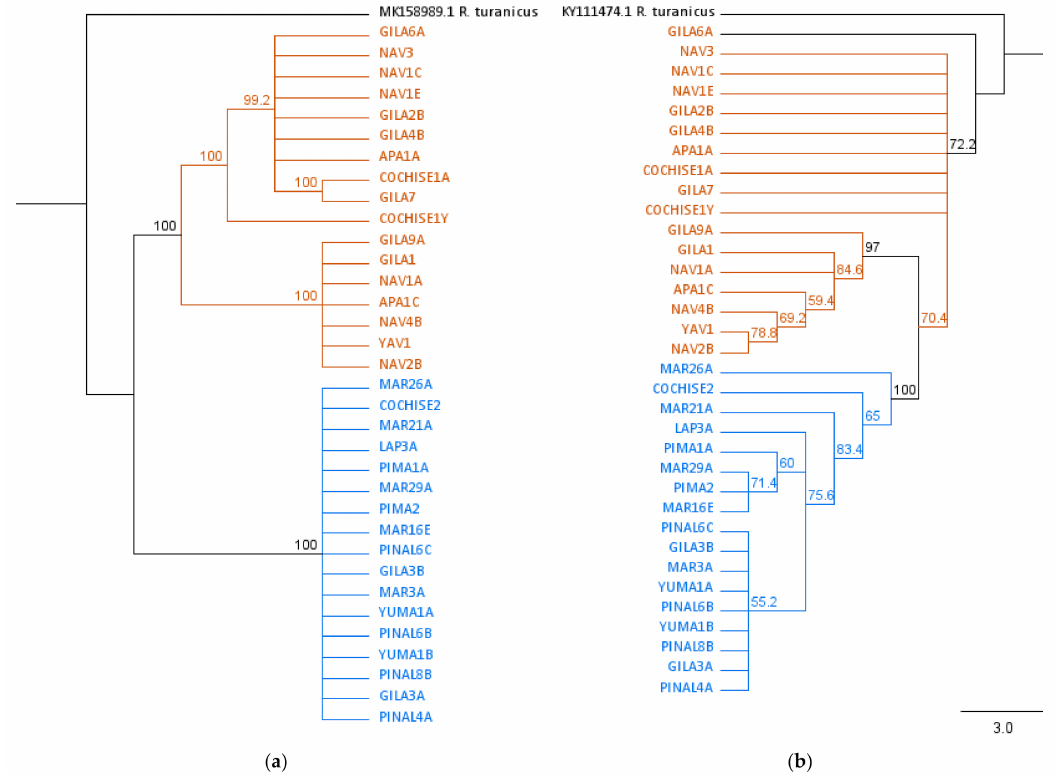
Figure 4. Maximum likelihood phylogenies of R. sanguineus s.l. ticks. Maximum likelihood trees based on partial R. sanguineus s.l. 12S rRNA ( a ) and 16S rRNA ( b ) sequences, rooted with R. turanicus sequences from NCBI GenBank. Ticks identified by diagnostic PCR as temperate lineage in orange, tropical in blue. Numbers at internal nodes represent support values from bootstrap based on 500